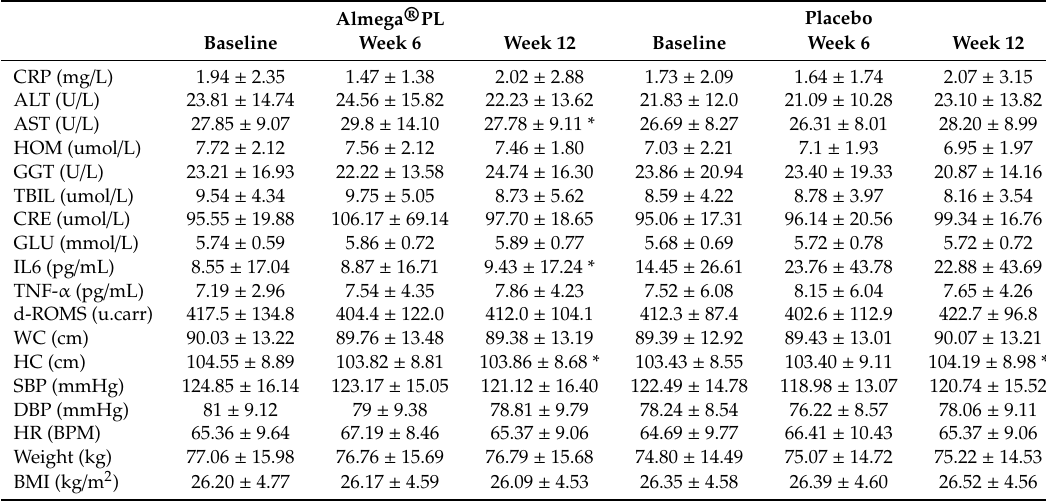
Table 4. Inflammatory, general safety markers, and anthropometric results for both the Almega ®® PL group and placebo group.